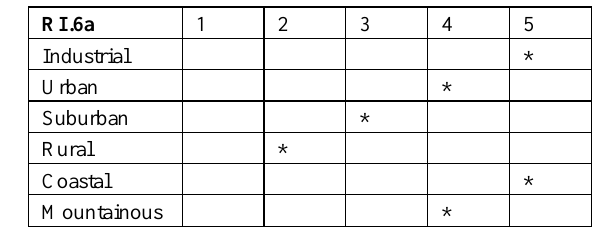
Table 8. Environment characterization